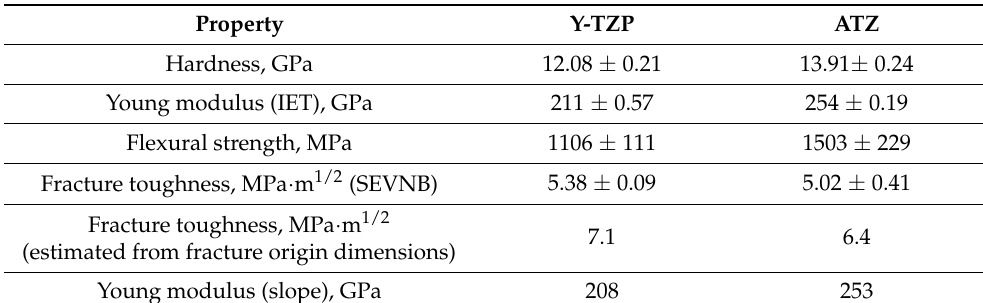
Table 2. Mechanical properties of yttria-stabilized zirconia (Y-TZP) and alumina-zirconia composite (ATZ) at room temperature.